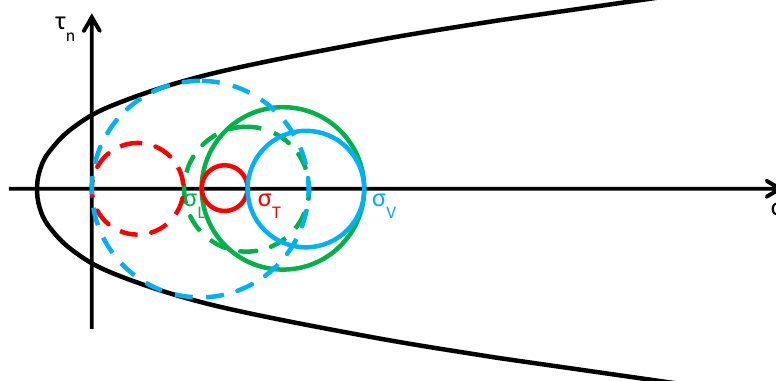
Figure 26. Stress analysis for σ L < σ T ≤ σ V (Mohr’s circles before retrofitting in dashed lines, comparison).